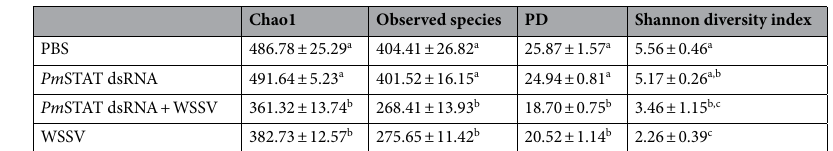
Table 1. Alpha diversity metrics for all the treatments. Species richness was measured using Chao2 and observed species index. Species diversity was calculated using Phylogenetic diversity (PD) and the Shannon diversity index. Different superscript lowercase letters in the same column indicate significant differences among conditions ( P < 0.01).